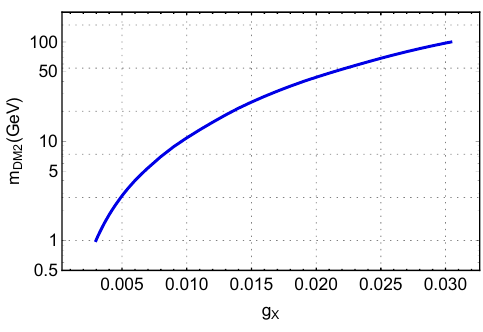
Figure 1 . The set of points in ( g X , m DM2 ) plane satisfying the relation Ω DM2 = 0 . 02 × Ω DM . In order for DM2-DR interaction to cause the desired suppression of the matter fluctuation at the scale k ’ 0 . 2 h Mpc − 1 , it should remain efficient until the time when 3 ρ / (4 ρ ) (cid:29) 1 is satisfied (slightly after recombination era). To this end, the mo- DM2 DR mentum transfer rate corresponding to ( g , m ) on the blue line in figure 1 should be X DM2 greater than the Hubble expansion rate until the late times. The momentum transfer rate reads